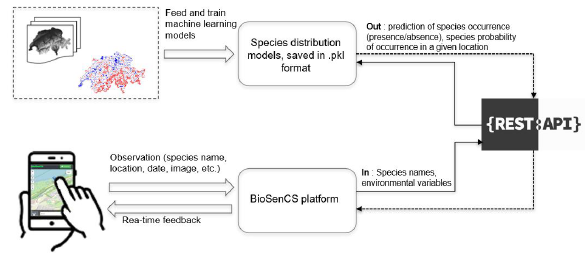
Figure 9. The process of automatic location validation and real-time feedback generation